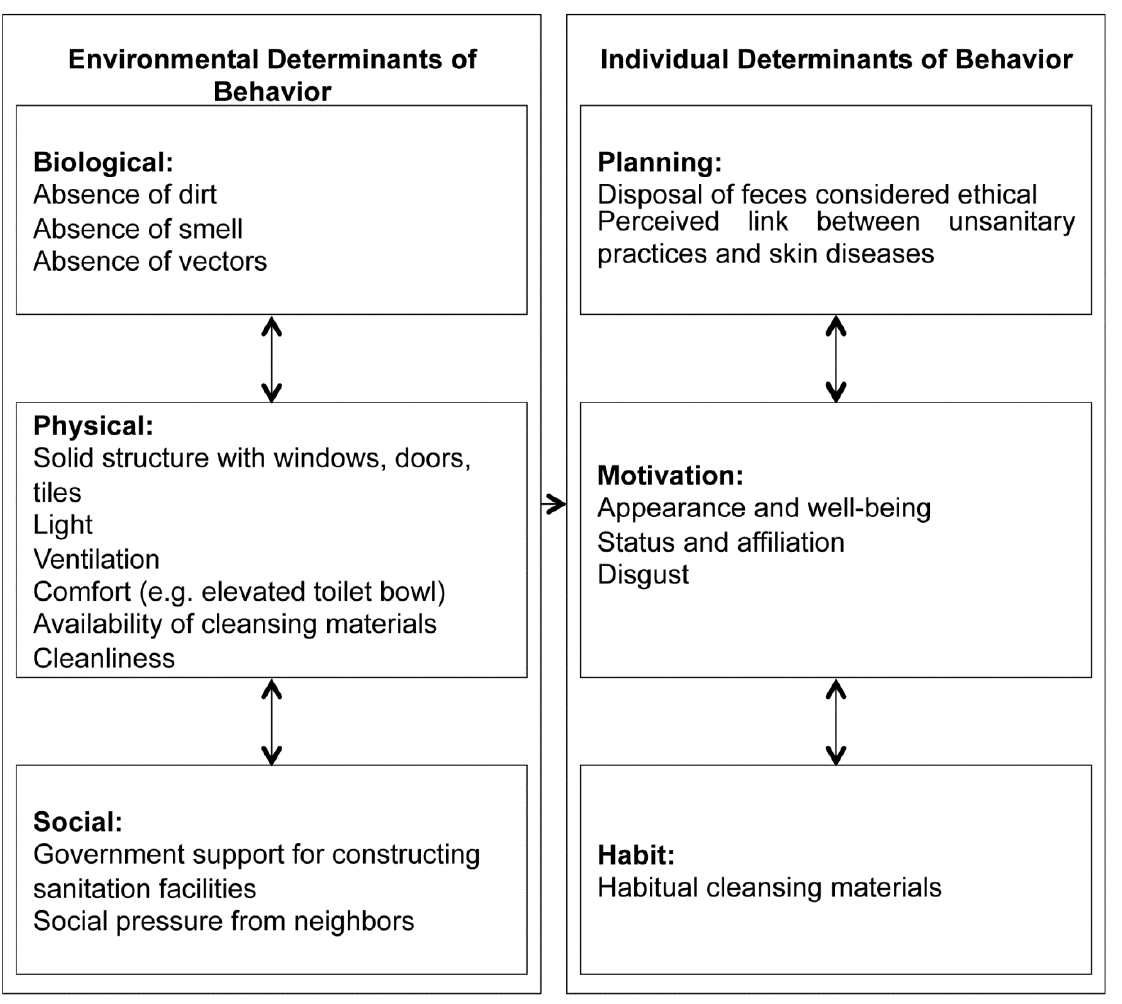
Figure 3. Major Determinants of Defecation and Anal Cleansing Behaviours, as Identified Through Thematic